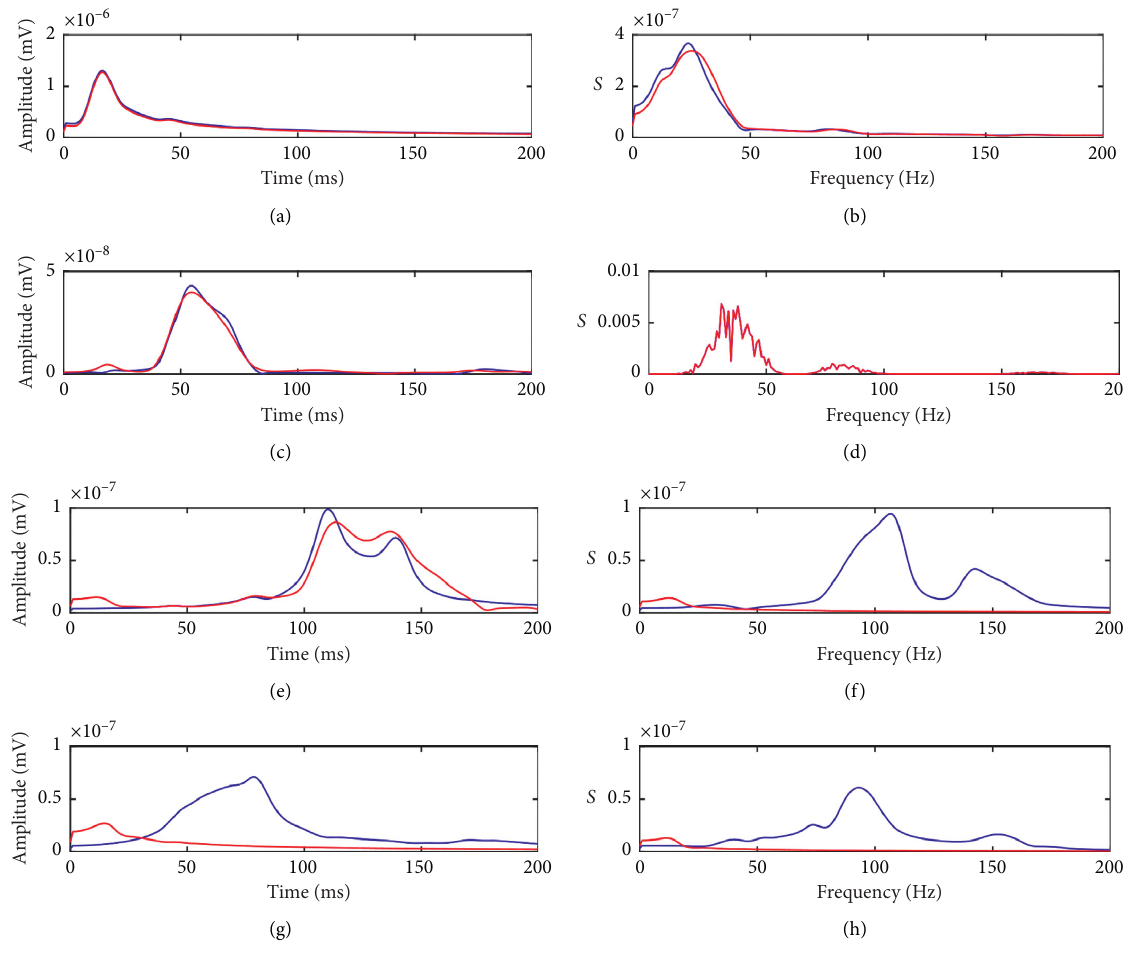
Figure 5: Illustration of MWPT denoising performance for S